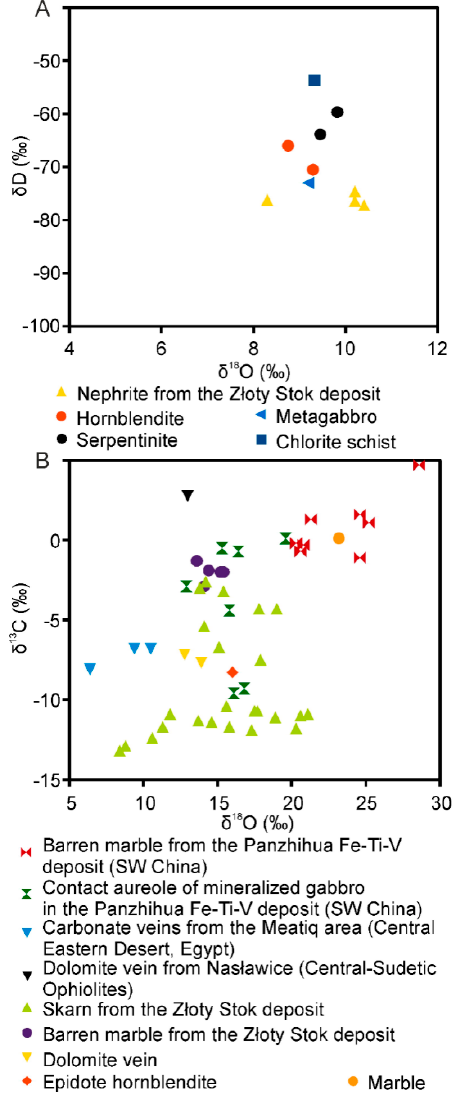
Figure 11. ( A ) The oxygen isotope composition ( δ 18 O) of silicate minerals separates vs. hydrogen isotope composition ( δ D) of bulk-rock samples. A nephrite from the Z ł oty Stok deposit, formed in the way of dolomitic marble replacement under the influence of granite-derived fluids, is presented after Gil et al. [31]; ( B ) The oxygen ( δ 18 O) vs. carbon ( δ 13 C) isotope composition of carbonates. The barren and mineralized marbles, and skarns from the Z ł oty Stok deposit, are presented after Mikulski and Speczik [63], the Panzhihua Fe-Ti-V deposit (SW China) after Ganino et al. [64], and carbonate veins within serpentinites of the Central Eastern Desert (Egypt) after Boskabadi et al. [66].